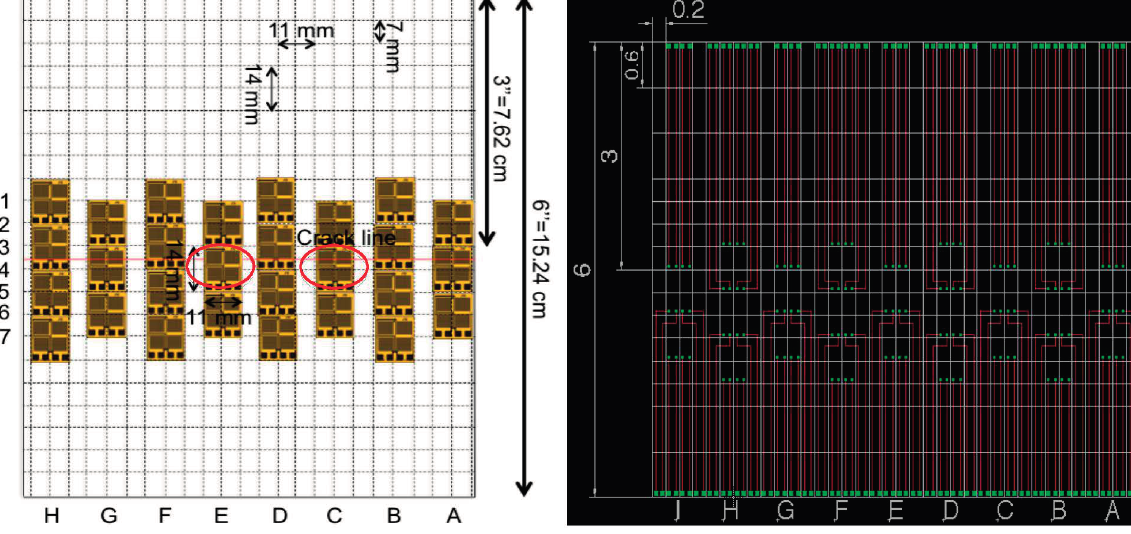
Figure 7. ( Left ): Scheme of sensing sheet Design 2; ( Right ): Corresponding EAGLE PCB